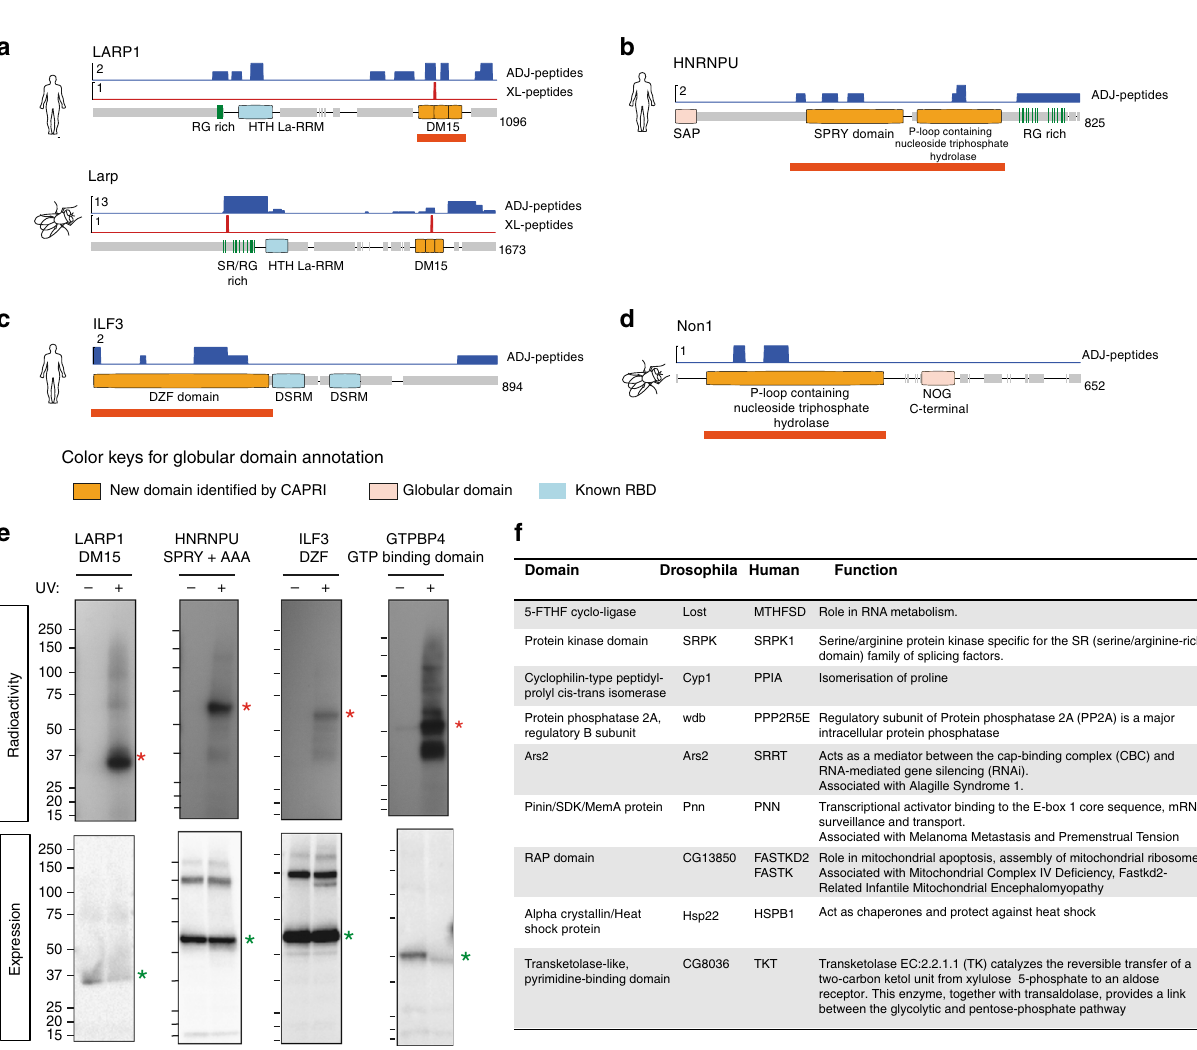
Fig. 8 Validation of globular domains by PNK assay. a Conservation of non-classical RBDs between Drosophila and humans exempli fi ed by the peptide coverage of Drosophila Larp protein. The tracks from top to bottom: ADJ-peptides (in blue), XL-peptides (in red), RG and RS rich region in the novel IDR (green bars), protein domains (classical RBDs in blue boxes, novel globular domains in orange boxes, other globular domains in faint pink boxes) and MobiDb disordered regions (grey bars) with protein length. b As in a for human RBP HNRNPU. c As in a for human RBP ILF3. d As in a for Non1 Drosophila protein (ortholog of human GTPBP4). e PNK assay performed to detect RNA-binding activity for the non-classical domains of the human proteins shown in a – d . Autoradiography (red asterisk) and western blot (green asterisk) using anti-Flag antibody after af fi nity puri fi cation of Flag-HBH-tagged domains in UV crosslinked ( + ) and non-crosslinked ( - ) HEK293 cells. From left to right: DM15 domain from LARP1, SPRY and AAA domains from HNRNPU, DZF domain from ILF3, and GTP-binding domain with Rossmann fold from GTPBP4. f Table describing a few notable conserved RBDs and their biological